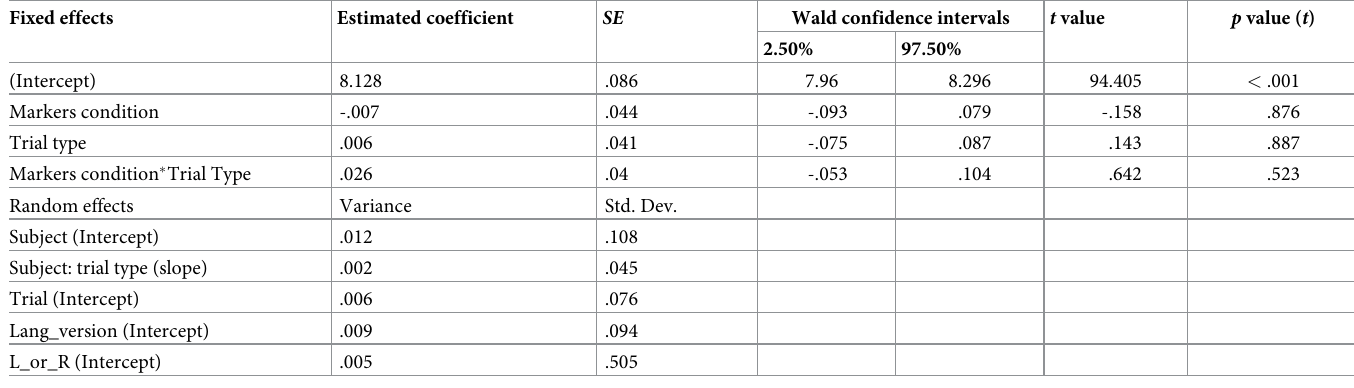
Table 4. Summary of the linear mixed-effects model of (log transformed) looking times on the categorisation trials in experiment 1. Fixed